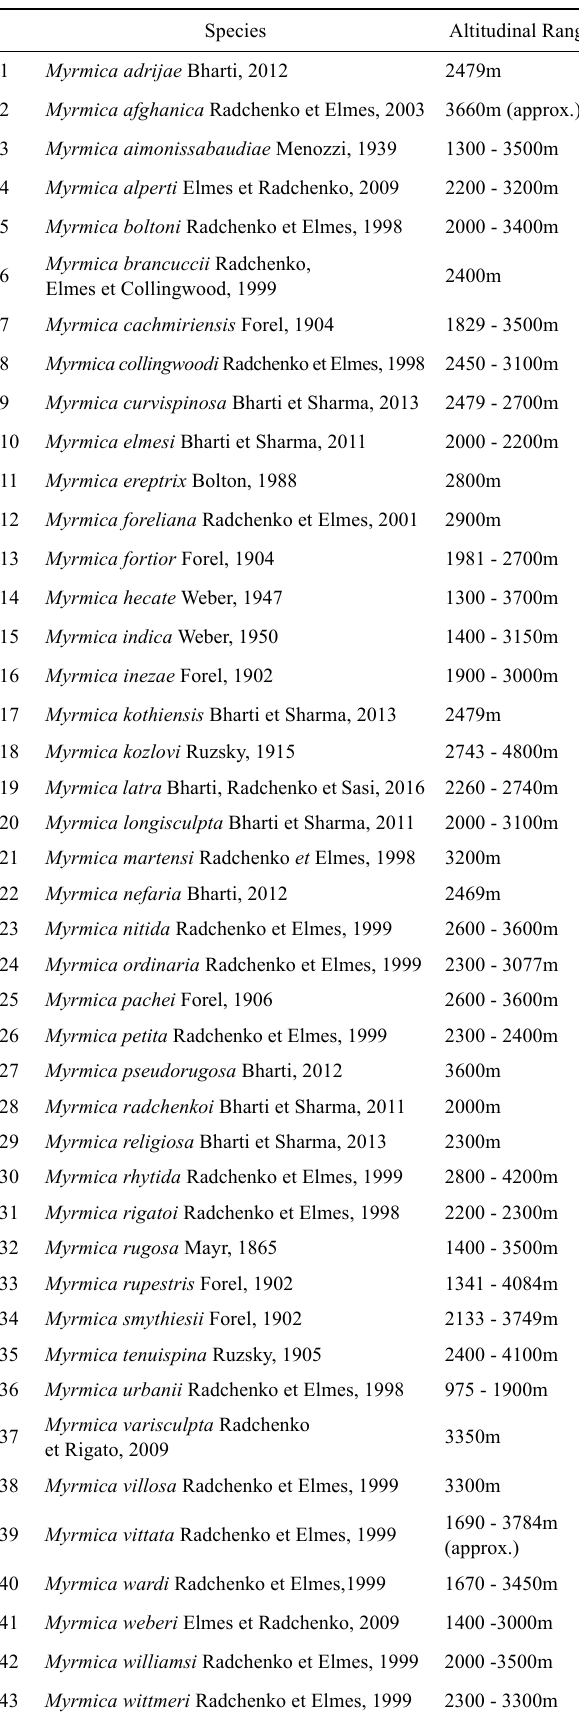
Table 1. List of Myrmica species with their altitudinal